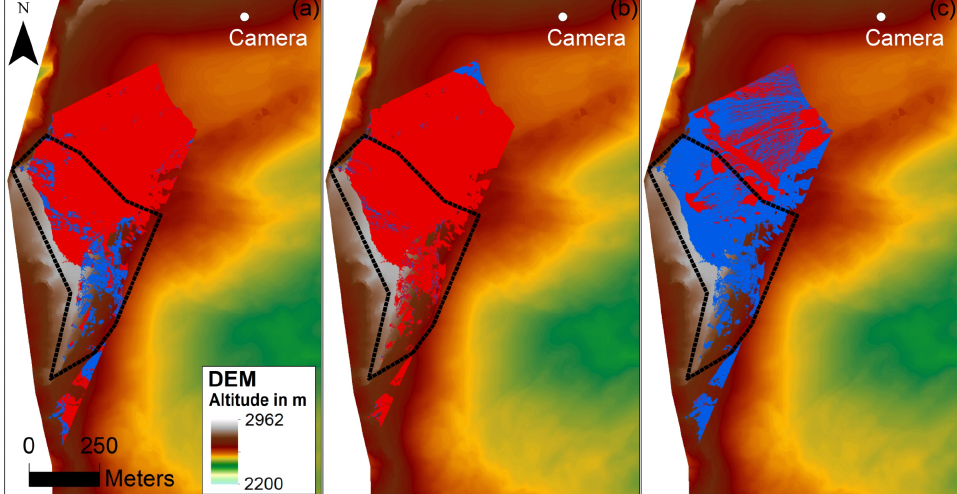
Fig. 10. The maps depict the resulting snow cover extent of the Fig. 9a (a) , 9b (b) , and 9d (c) . The black dashed line outlines the investigation area at the Schneefernerkopf. We want to note here that the small test area (black box in Fig. 9d) is not shown in (c) .